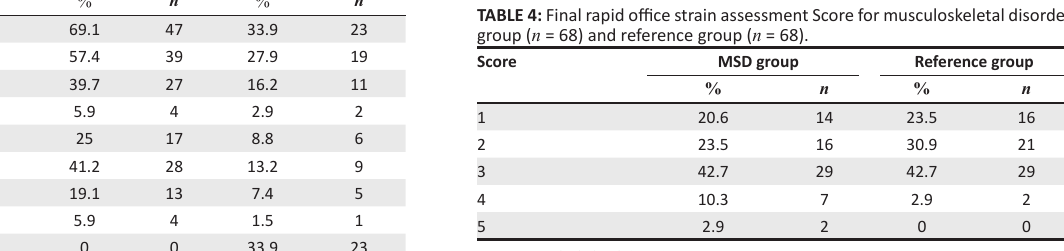
TABLE 2: Previous 12 months and 7 days prevalence in musculoskeletal disorders by location ( n = 68). Location